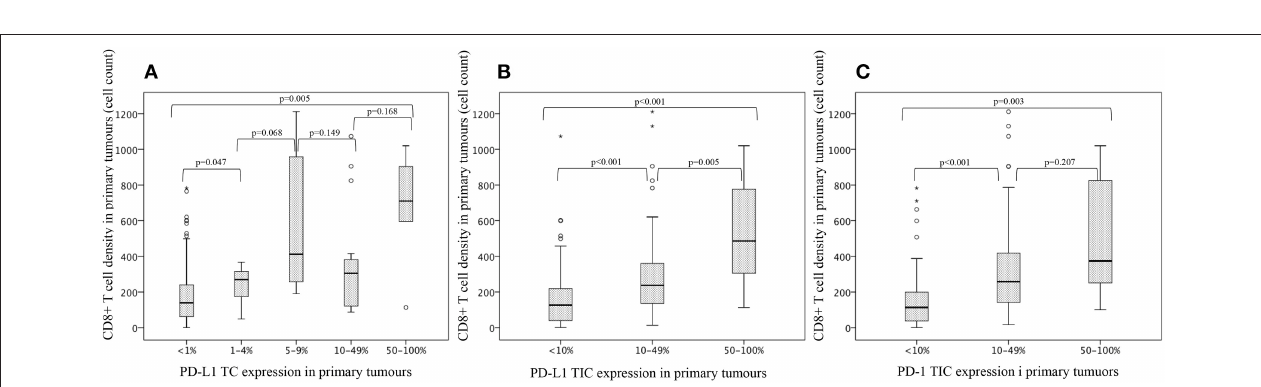
FIGURE 6 | Kaplan-Meier estimates of OS in strata according to MMR status in (A) the entire cohort, p = 0.626, (B) esophageal tumours, p = 0.824, and (C) gastric tumours, p = 0.740.